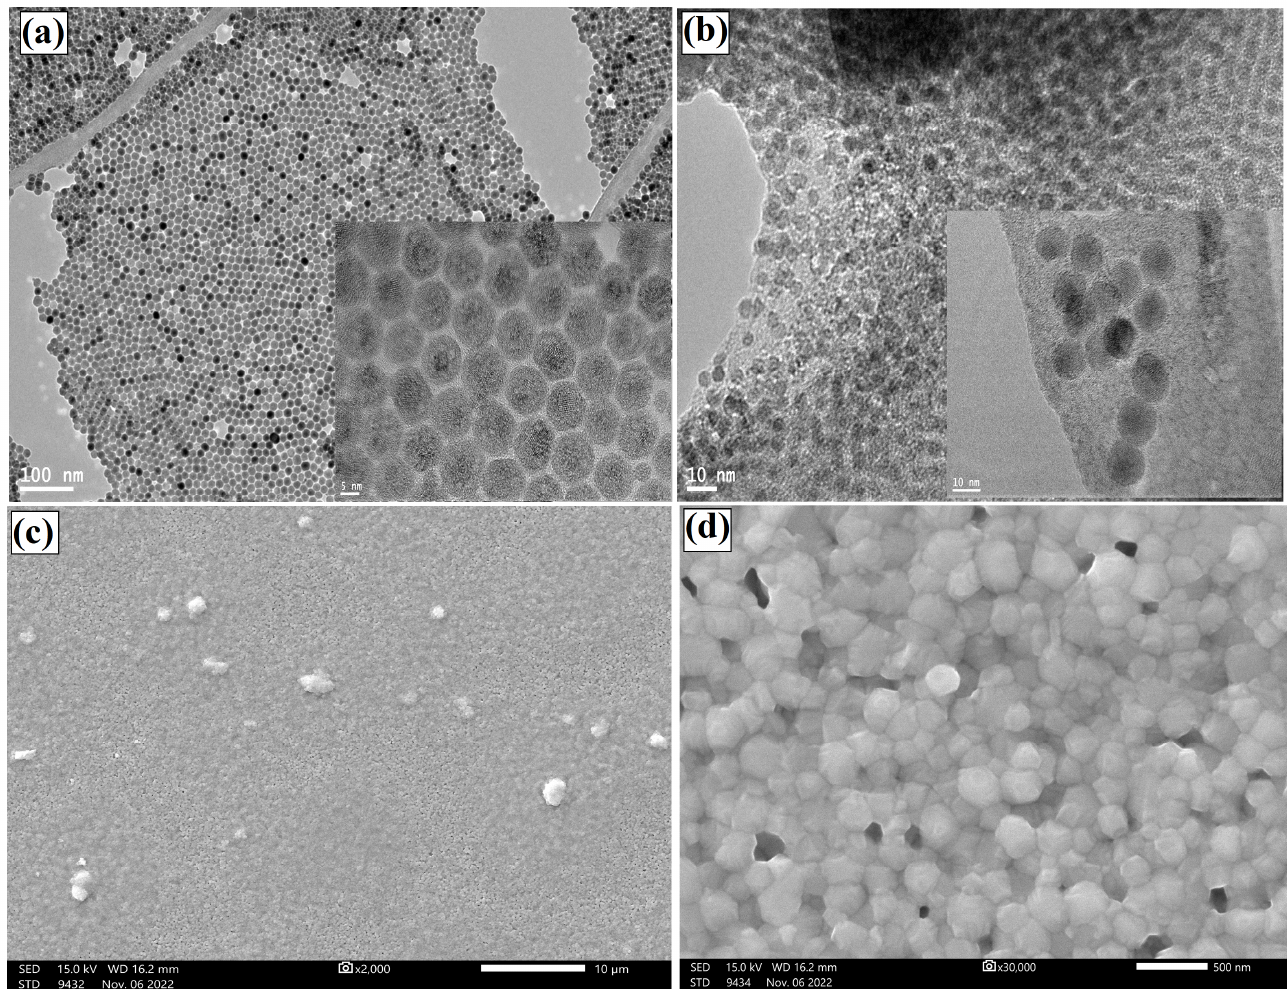
Figure 2. Structural characterization of the synthesized UCNPs and CQDs. ( a ) High- and low-magnification TEM images of the synthesized UCNPs. ( b ) TEM images of the synthesized CQDs with an average size below 10 nm. ( c ) Low-magnification SEM image of the CQDs mixed with the perovskite materials and spin-coated on a quartz slide. ( d ) High-resolution SEM image of the prepared hybrid materials.